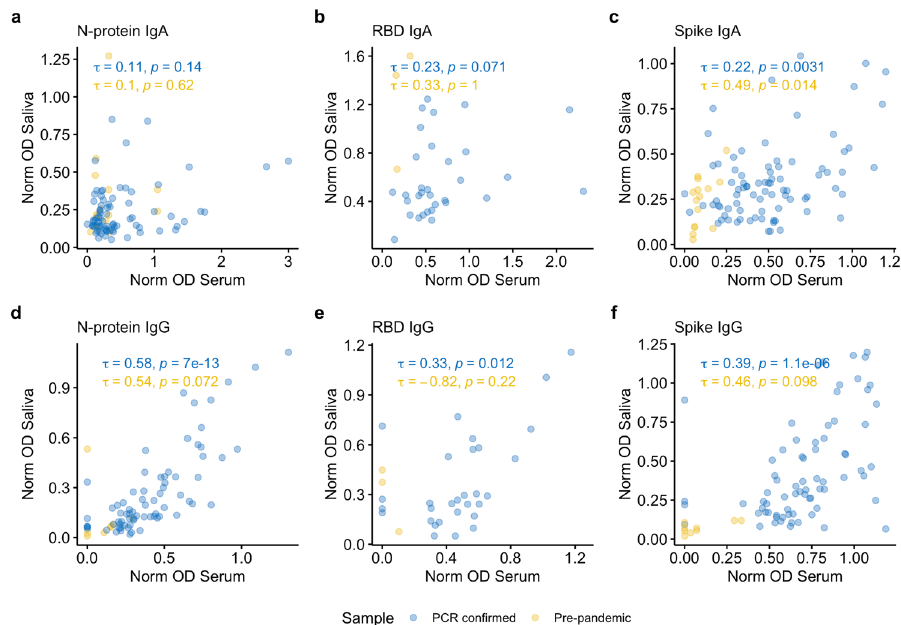
Fig. 4 Correlation between mucosal and systemic antibody. a – f Correlation between serum and salivary IgA and IgG responses to spike protein, nucleocapsid protein (N-protein) and receptor binding domain (RBD) a , d N-protein IgA ( N = 91) and IgG ( N = 80) assays. b , e RBD IgA ( N = 35) and IgG ( N = 33), c , f spike IgA ( N = 97) and IgG ( N = 81). PCR-con fi rmed samples are shown in blue and pre-pandemic samples are shown in yellow. Correlations (Kendall ’ s tau) were performed for paired saliva and serum samples collected on the same day.